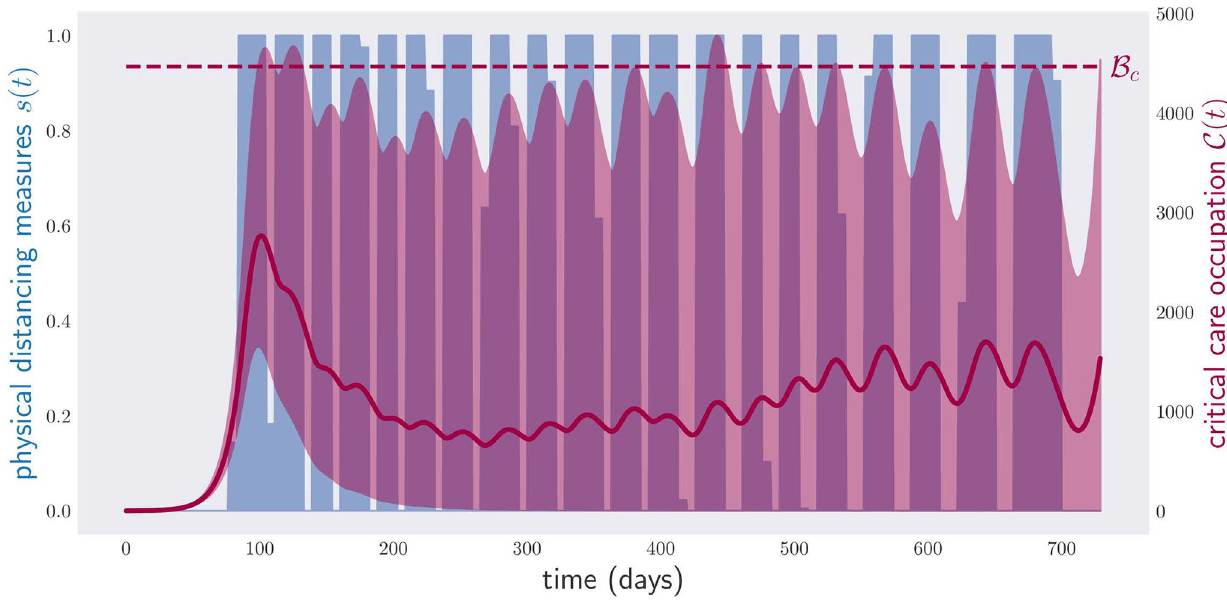
Fig 11. Occupation of critical care beds (red) and (optimized) physical distancing measures (blue) for a period of two years under random parameters in N . The disease control policy was optimized to respect condition (2) over the whole range of parameters N 0 : 25 red depicts again the range of critical care occupations observed in a sample of 1000 model parameters in N